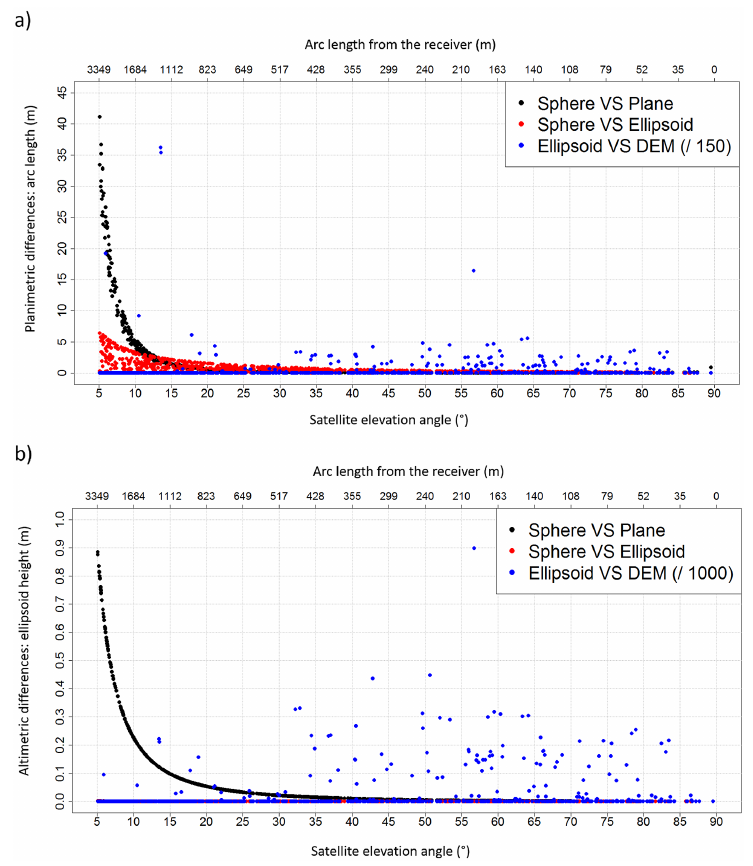
Figure 13. Planimetric and altimetric differences between the specular reflection points obtained with the different algorithms. Receiver height above the reflecting surface: 300m. (a) Planimetric differences as arc length (m). (b) Altimetric differences as ellipsoid height (m). Note the dispersion within results for a fixed elevation angle, which is a consequence of the azimuth variability in the ellipsoidal radius of